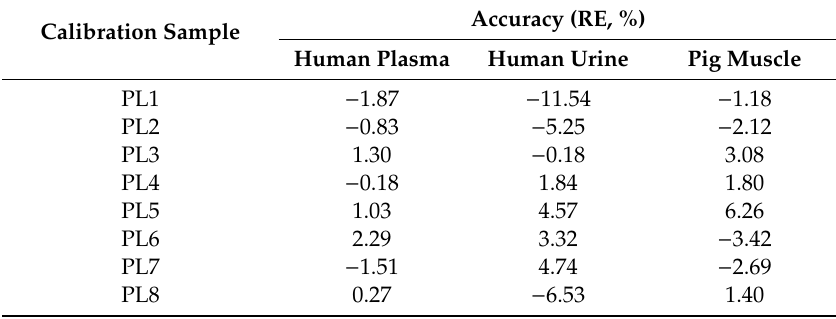
Table 1. Accuracy of the back-calculation concentrations on two samples in human plasma, human urine, and pig muscle